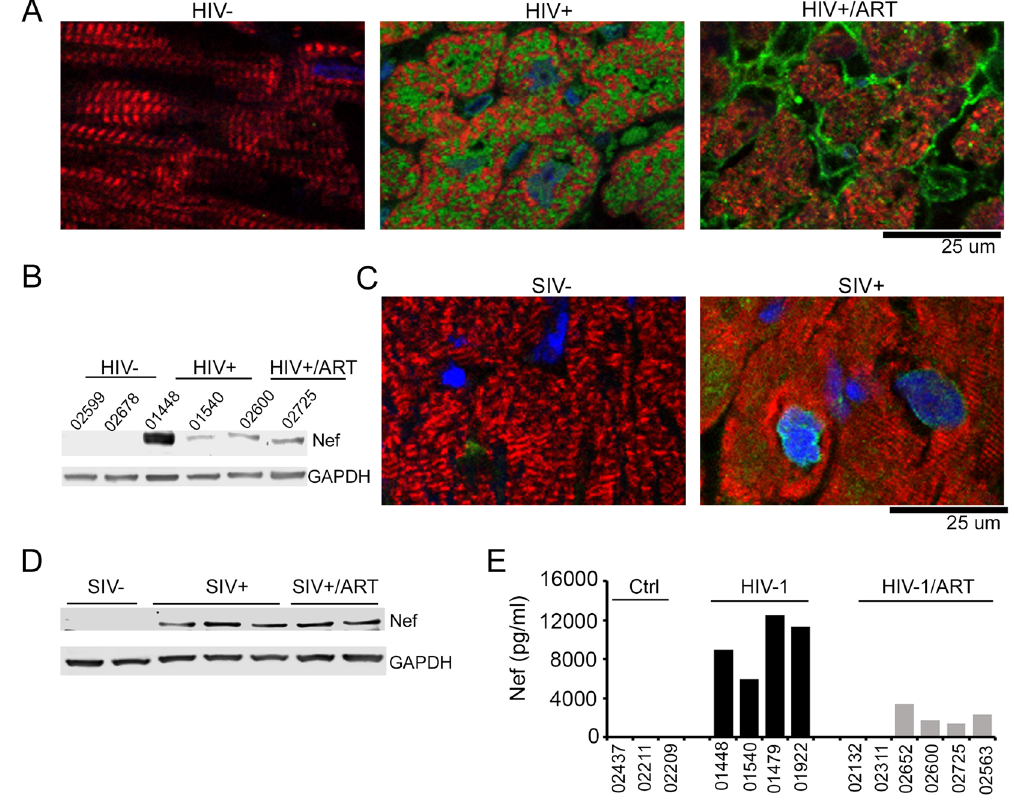
Figure 1. Nef protein is localized within cardiomyocytes in heart tissue of HIV-1 positive patients and SIV- infected macaques: ( A ) Representative images show the localization of Nef protein in heart tissue of HIV-1 positive patients treated (HIV + /ART) or not treated with ART (HIV + ) but not in HIV-1 negative (HIV − ) control. PFA-fixed human heart tissue sections were stained with antibodies directed against Nef (green) and cardiomyocyte marker protein Troponin I (TnI) (red). ( B ) Western blot analysis shows the presence of Nef protein in heart tissue lysates of HIV + and HIV + /ART patients, but not HIV- subjects. The numbers represent the PROJID for each clinical samples obtained from NNTC. ( C ) Representative images show the presence of Nef protein in the cardiomyocytes of control (SIV − ) or SIV-infected (SIV + ) macaque heart tissue sections. Frozen heart tissue sections were fixed with acetone and stained with Nef-specific antibody (green) and TnI (red). ( D ) Western blot shows the presence of Nef protein in SIV-infected macaque hearts treated (SIV + /ART) and not treated (SIV + ) but not in SIV − controls (SIV − ). Blots were probed with antibody against SIV Nef ( E